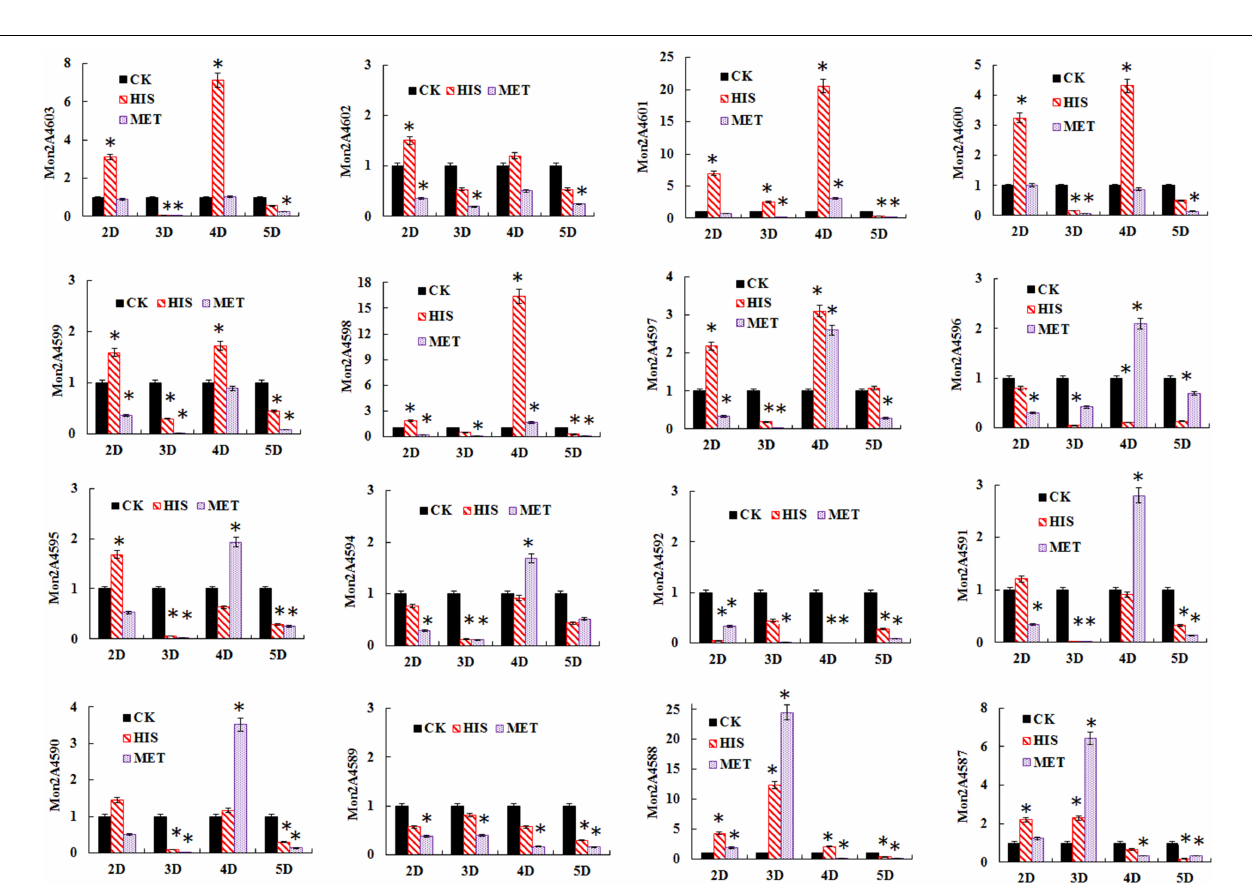
FIGURE 7 | Gene transcription profile of the polyketide synthase (PKS) cluster in Monascus purpureus RP2 fermentation with HIS and MET. CK, M. purpureus RP2 fermentation without the addition of amino acid; HIS, M. purpureus RP2 fermentation with the addition of HIS; MET, M. purpureus RP2 fermentation with the addition of MET; D, fermentation time (Day). Bars with asterisks (*) are significantly different ( P < 0.05).